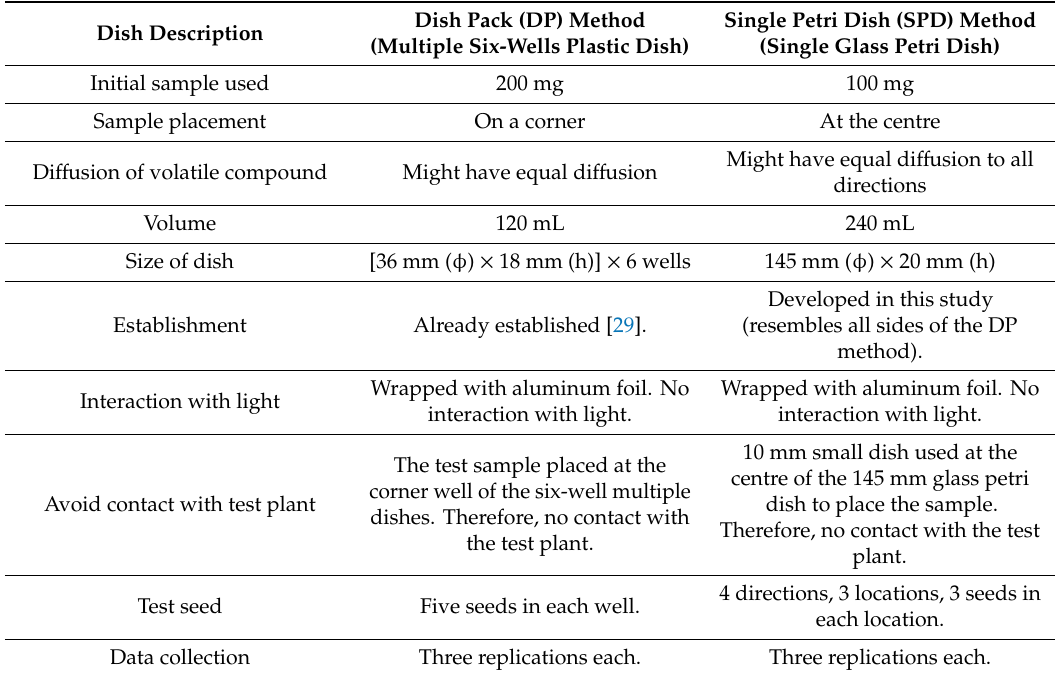
Table 1. Brief description of the DP method and the SPD